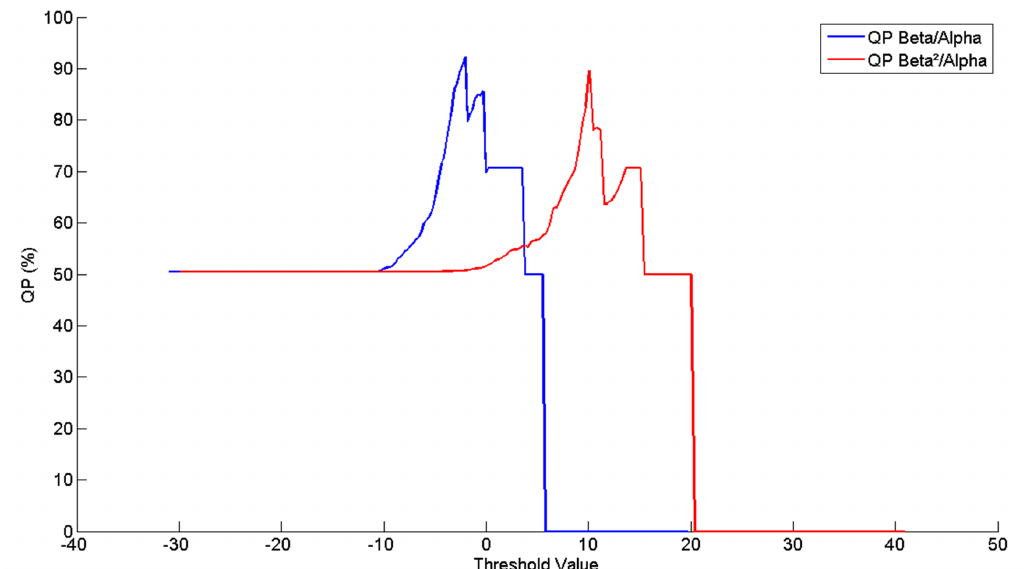
Figure 13. Relationship between the threshold of ERD/ERS and the QP. Threshold varying from mean – 10*SD to mean + 10*SD (steps of 0.1). QP is expressed in